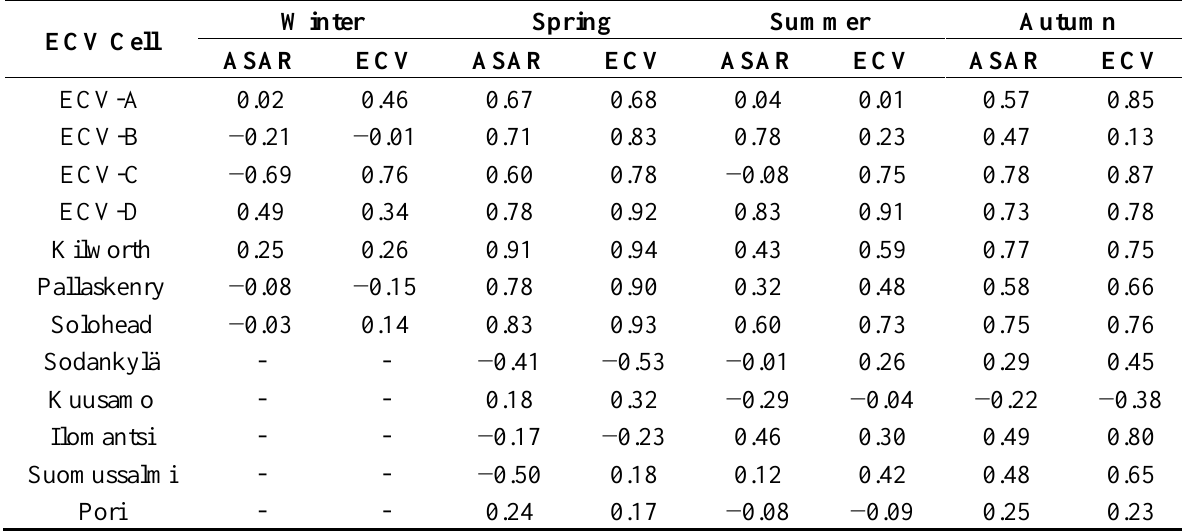
Table 8. Seasonal correlation values (R) between in situ SM measurements and both ASAR and ECV SM datasets, evaluated in each ECV cell under